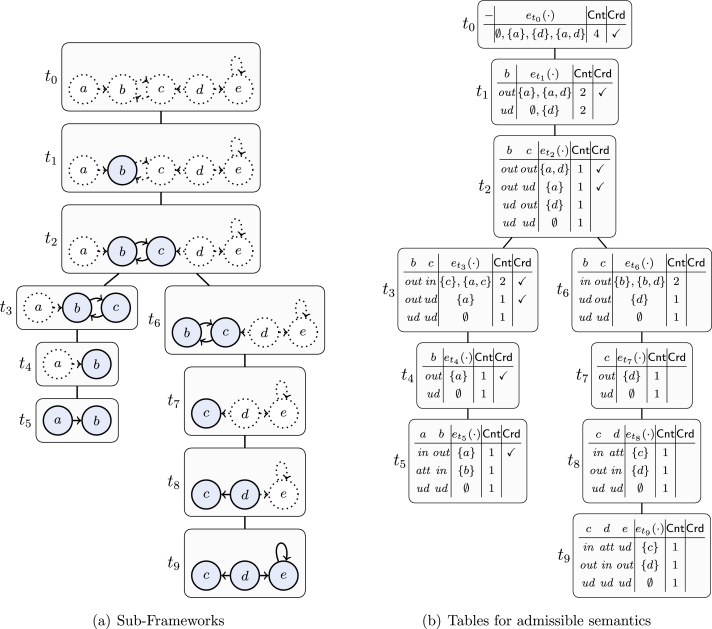
Normalized tree decomposition in action.